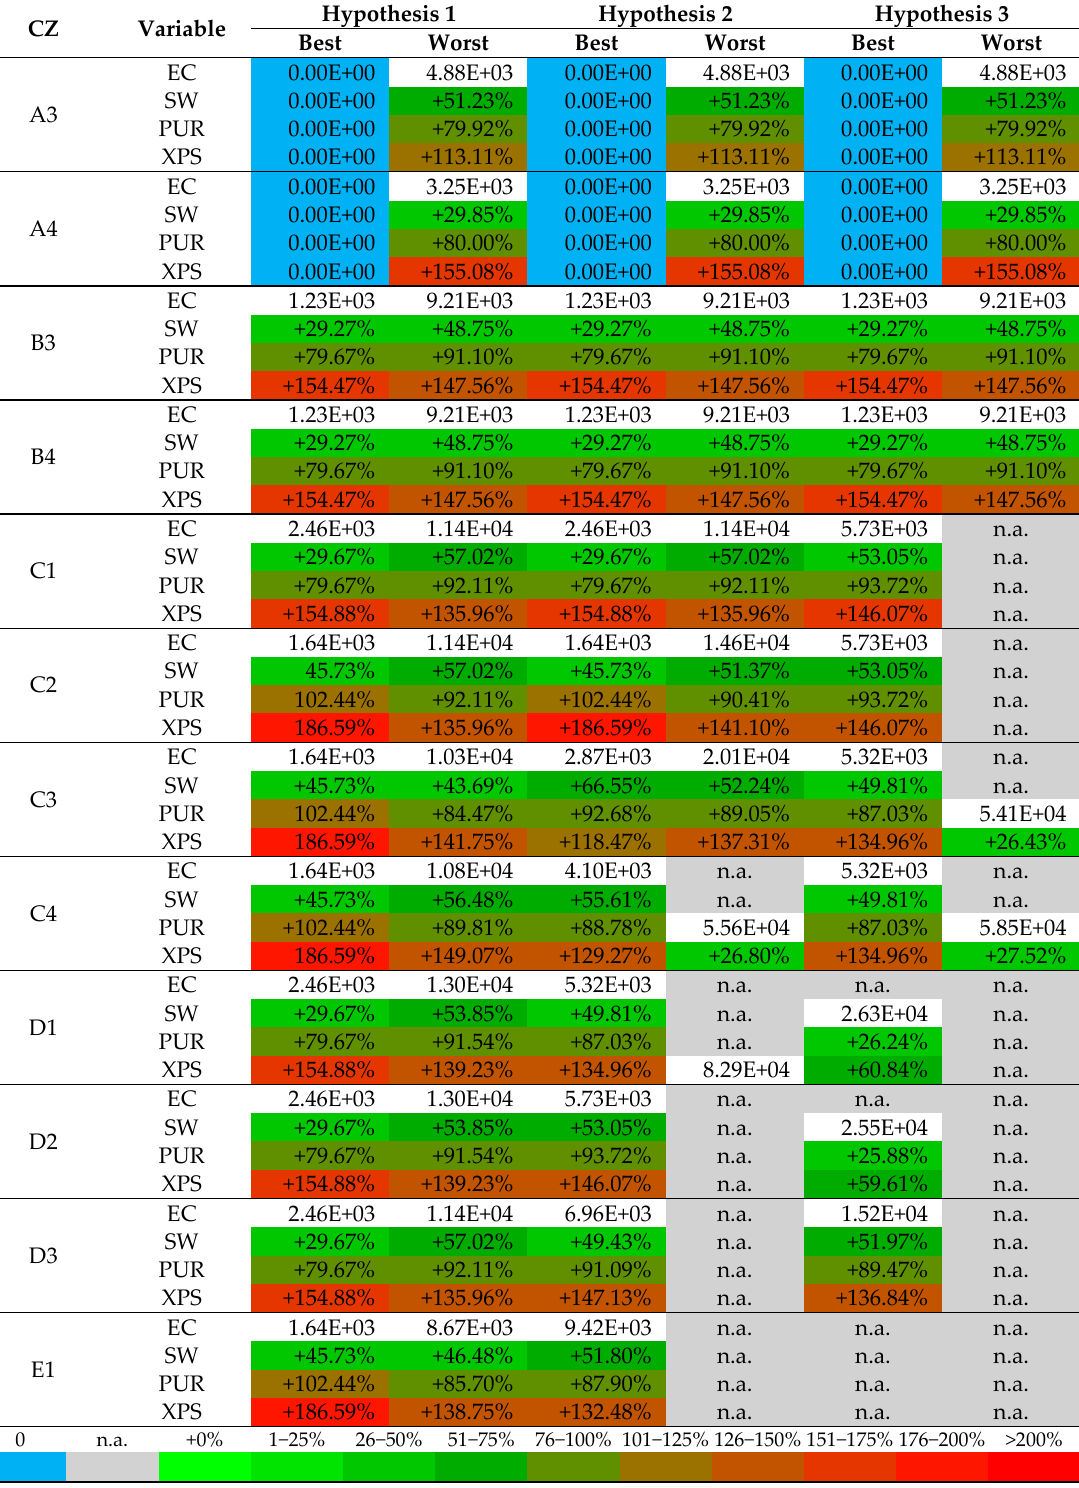
Table 7. Increase of emissions according to the insulation material for the best and worst set ups.